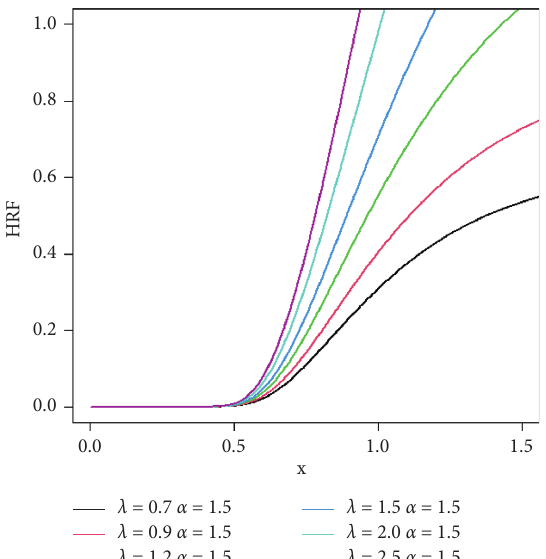
Figure 2: HRF plots for the SHLIR